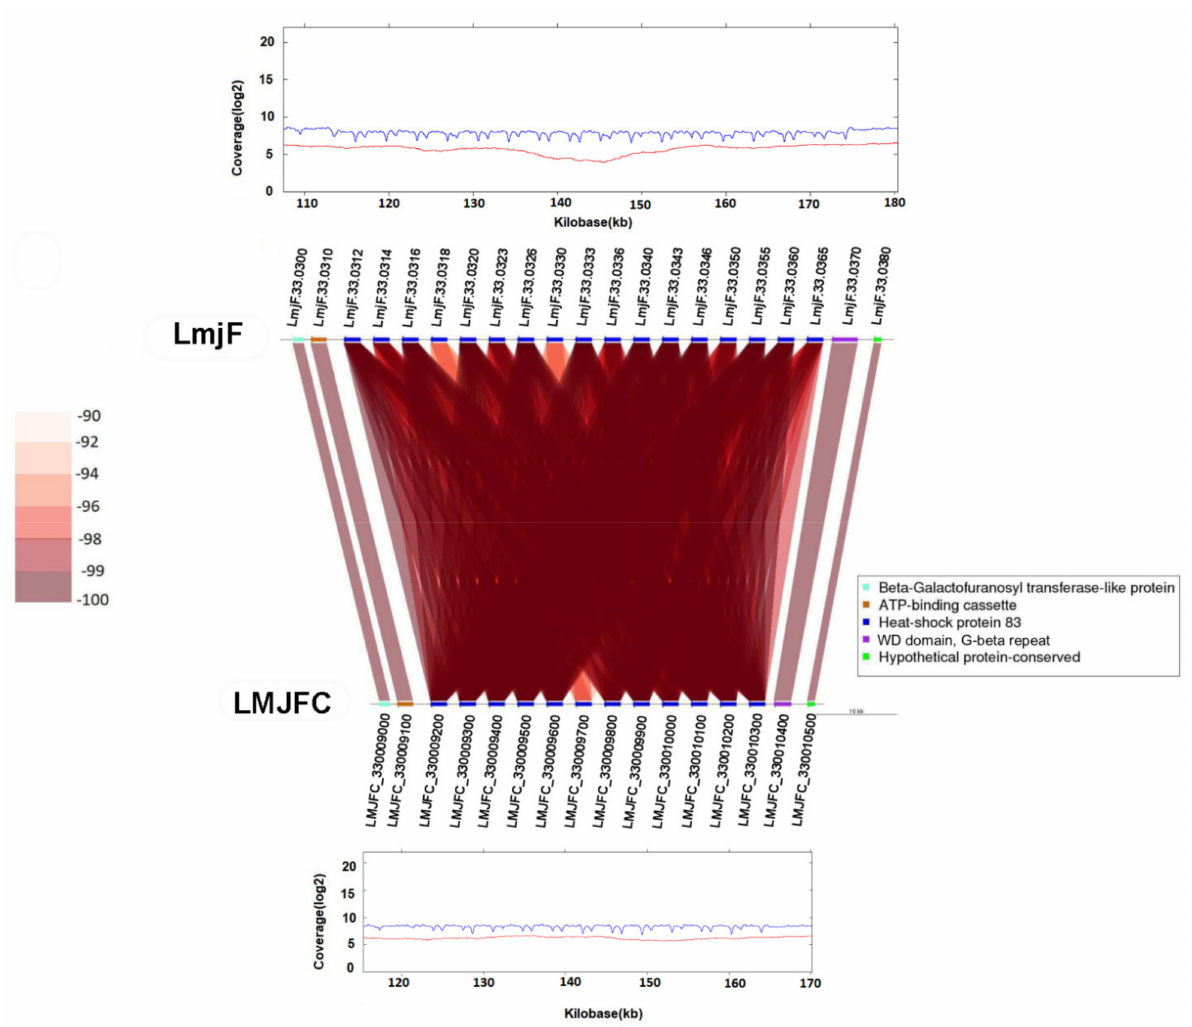
Figure 3. Different gene copy number in the HSP83/90 locus are assembled in either LmjF or LMJFC chromosome 33. Gene sequence identity is shown according to a color-intensity scale. The upper and bottom graphs show the coverages of Illumina reads (in blue) and PacBio reads (in red) mapped to this chromosomal region in the LmjF and LMJFC assemblies,